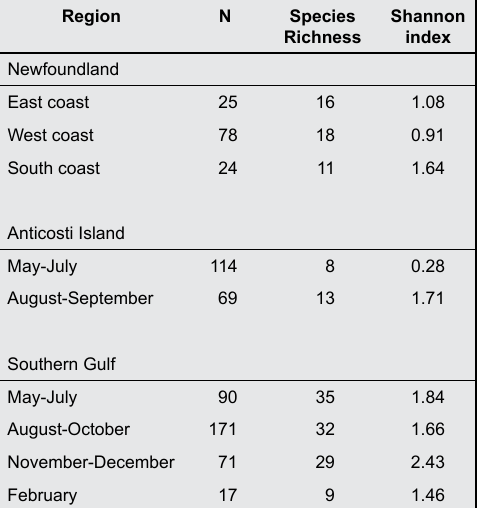
Table 2 . Species richness and Shannon indices for grey seal diet samples from Newfoundland, Anticosti Island and the southern Gulf.